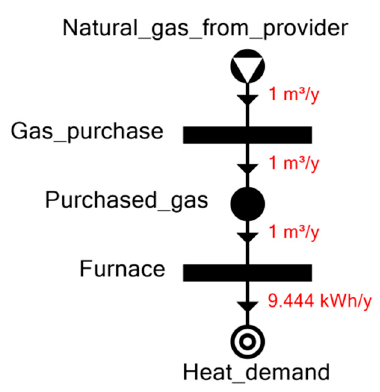
Figure 4. Natural gas purchase and built-in furnace of the plant used in the P-Graph.